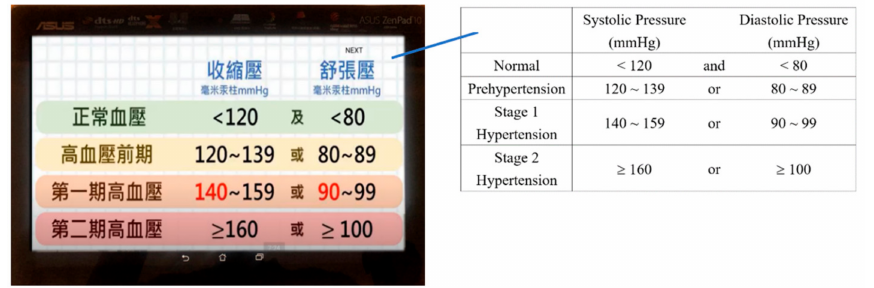
Figure 2. The video-assisted learning